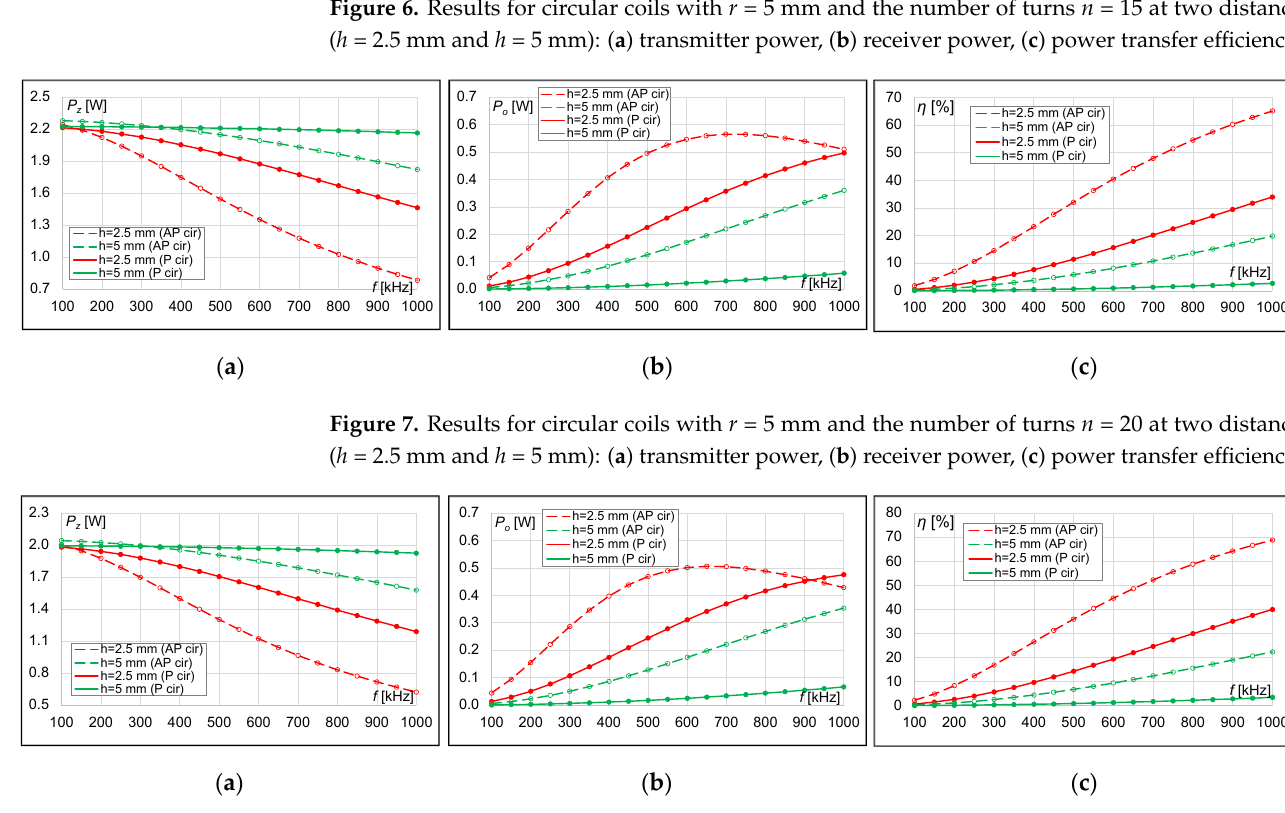
Figure 8. Results for circular coils with r = 5 mm and the number of turns n = 25 at two distances ( h = 2.5 mm and h = 5 mm): ( a ) transmitter power, ( b ) receiver power, ( c ) power transfer efficiency.